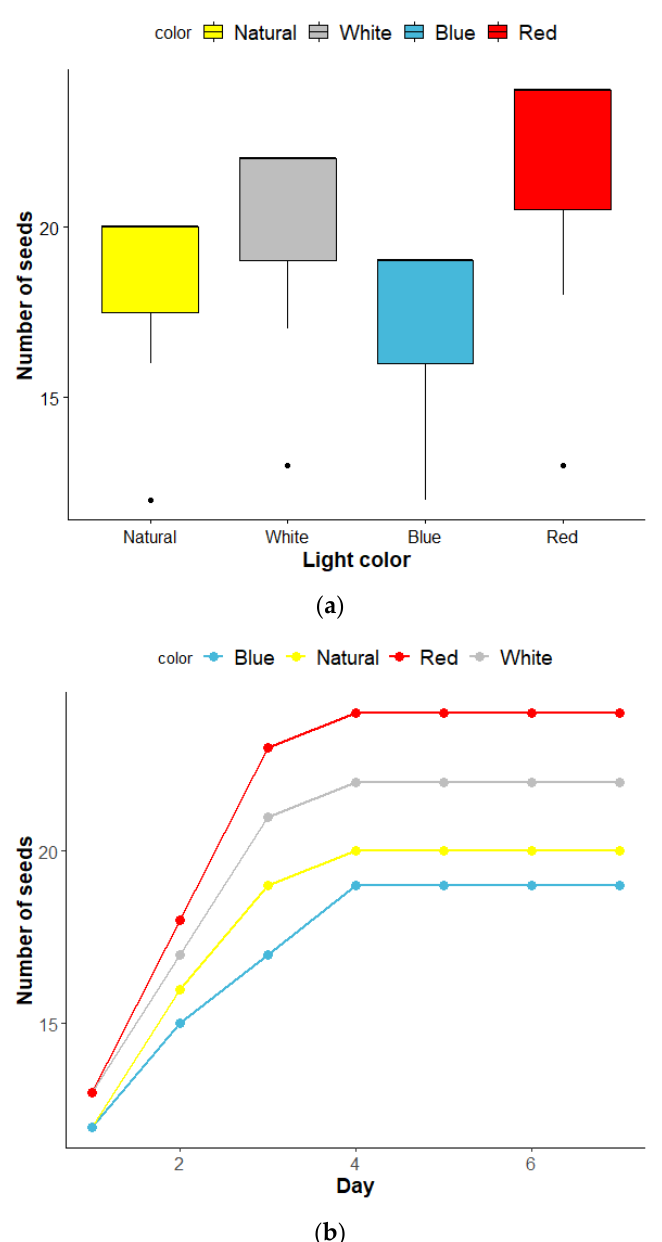
Figure 7. Germination number of seeds under red (3R1B), blue (1R5B), white (full spectrum), and natural light treatments for each plant nursery: ( a ) comparison between treatments; ( b ) number of germinated seeds per day. Table 1. Exponential rise to maximum with the germinated seed with the time.